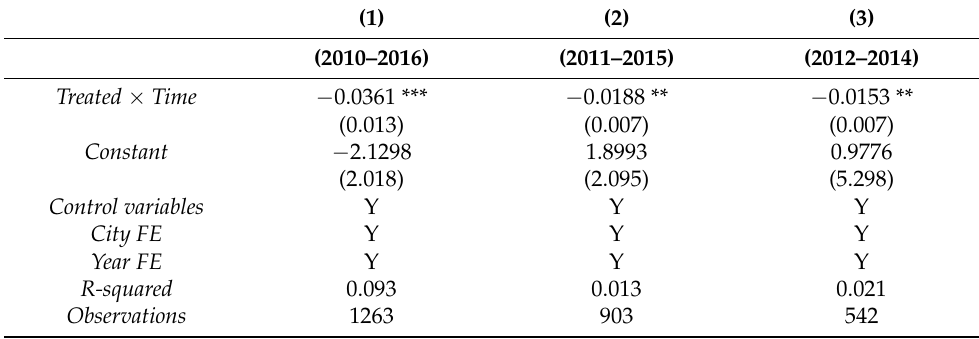
Table 6. Robustness test of changing the period of the policy implementation.